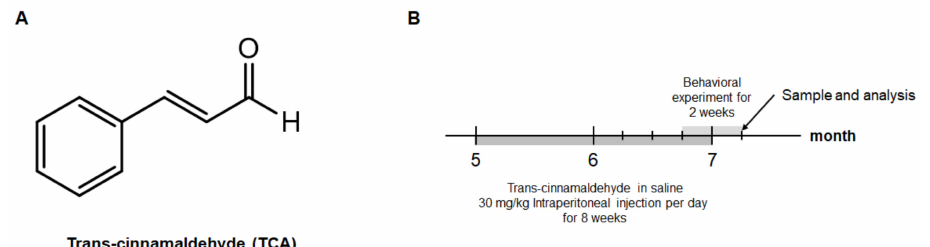
Figure 1. The chemical structure of trans-cinnamaldehyde (TCA) and experimental design. ( A ) TCA derived from the cinnamon contains an aldehyde structure. ( B ) Five-month-old 5XFAD was injected intraperitoneally with 30 mg / kg of TCA per day for eight weeks. After behavioral analyses, mice were sacrificed and brain samples were collected for further analysis.